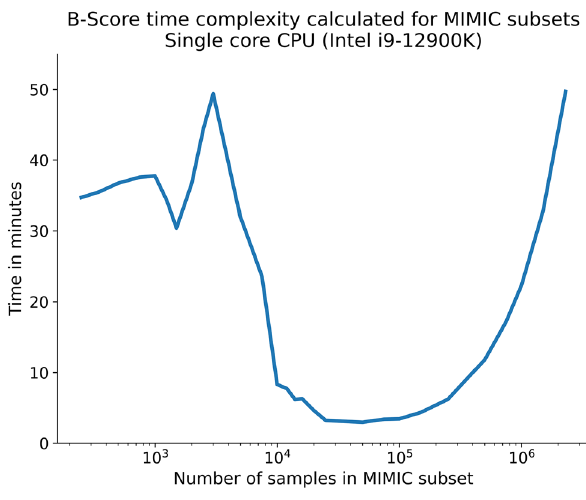
Figure 8. Time complexity analysis for B-Score calculation derived from MIMIC IV subsamples increasing in size. The x-axis is scaled logarithmically to allow visual